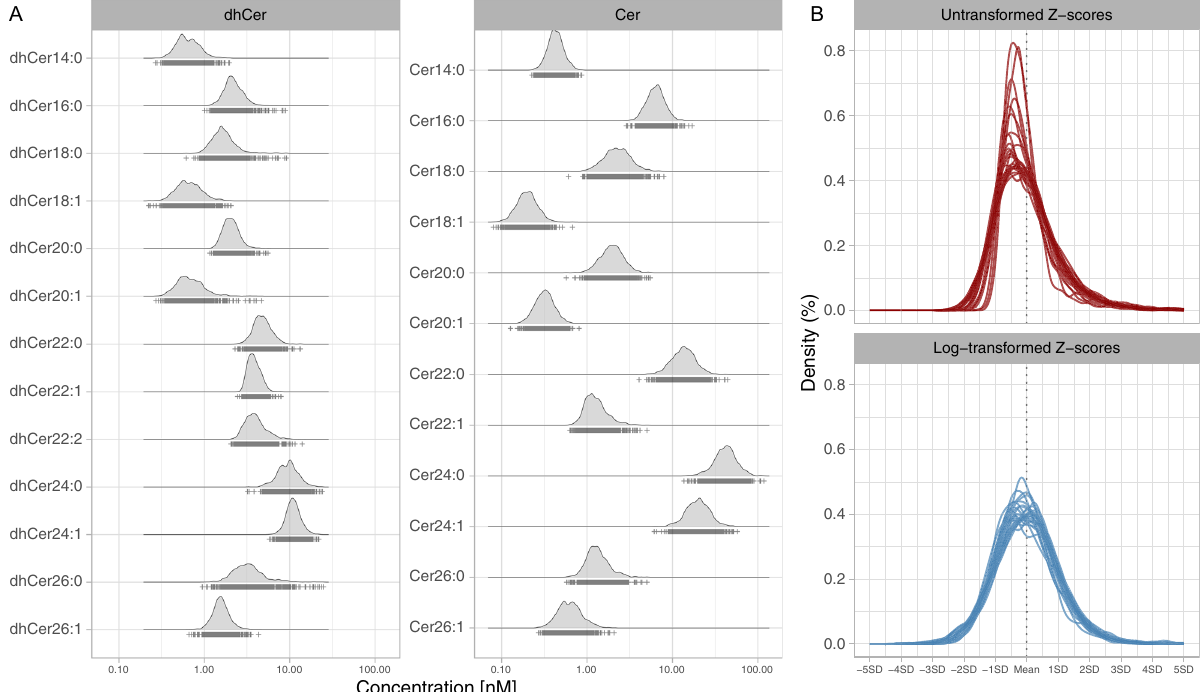
Fig. 1 Distribution of ceramide and dihydroceramide measurements. A Distribution of the absolute (dh)ceramide plasma concentrations; note that the x - axis is log scaled. B Comparison of Z-scores derived from the non-transformed and log-transformed (dh)-ceramide plasma concentrations. Cer ceramide, dhCer